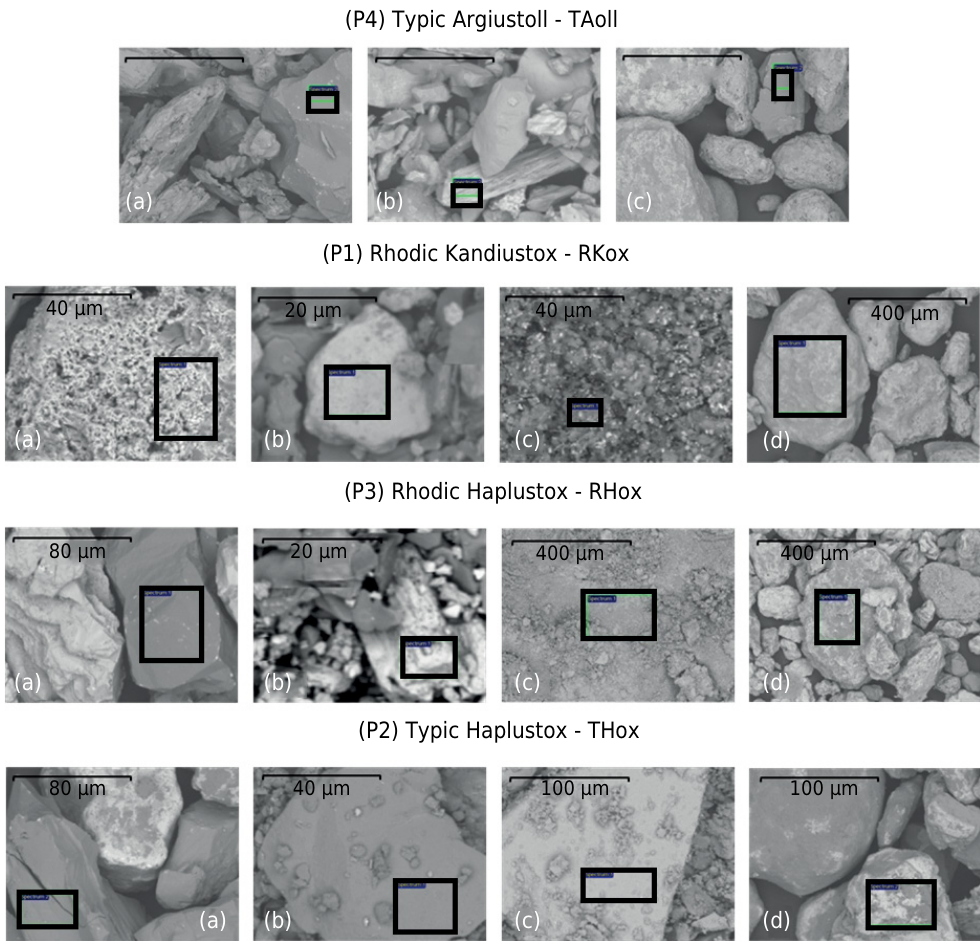
Figure 6. Scanning electron microscopy for the (a) sand, (b) silt, and (c) clay fraction and (d) magnetic extract from the diagnostic horizons of the soils. The fields marked as square labels refer to probing points by energy dispersive